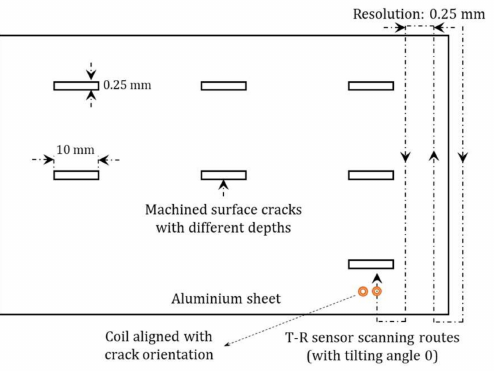
Figure 4. Scanning route of tilted T-R sensor for electromagnetic imaging of aluminium sheet with machined surface slots of different